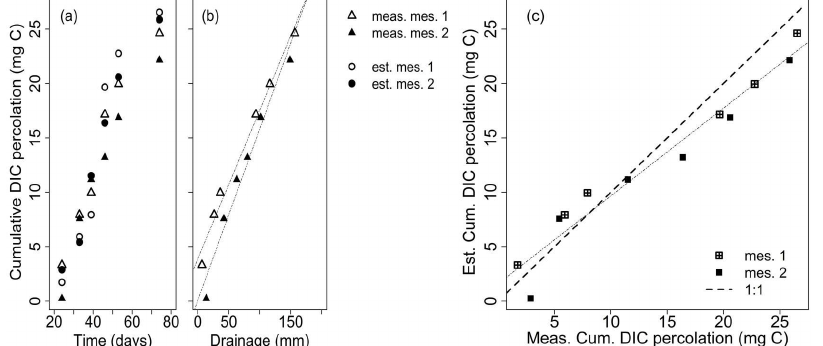
Fig. 4. Directly measured and estimated cumulative DIC percolation vs. time (a), directly measured cumulative DIC percolation vs. cumulative drainage (b) and estimated vs. directly measured cumulative DIC percolation (c). The estimated DIC percolation was calculated from alkalinity, p CO 2 and water flux. Bold stippled lines indicate closure of the outlet. Narrow dot- dashed lines in b) and c) are regression lines; in (c) the regression comprises both mesocosms.